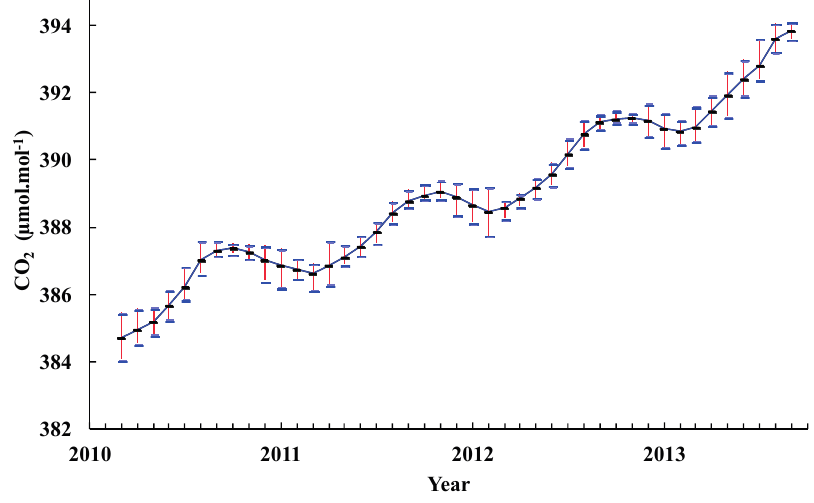
mole fraction at Zhongshan Station and the time sequence Figure 8. Average monthly CO 2 of its maximum and minimum values indicated by the red/blue lines (2010 through 2013). mole fractions variability of every month, The vertical bars stand for the amplitude of CO 2 which is higher in the austral